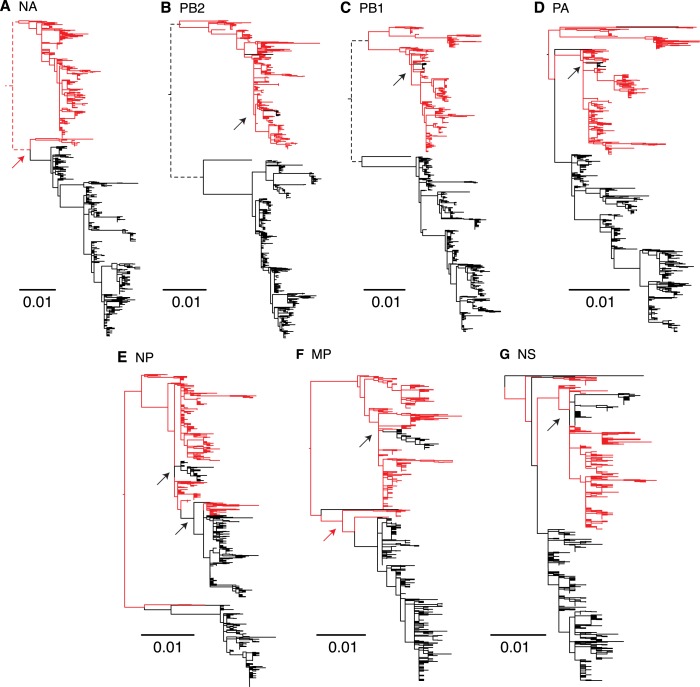
Genome wide evolutionary dynamics—reassortment.Evolutionary relationships of neuraminidase (A), polymerase
basic 2 (B), polymerase basic 1 (C), polymerase
acidic (D), nucleoprotein (E), matrix
(F), and non-structural (G) genes of Victoria
and Yamagata lineage viruses inferred using the maximum likelihood analysis
of 908 full genome sequences. Lineages are coloured based on the HA lineage:
Victoria (black) and Yamagata (red) and arrows highlight inter-lineage
reassortment.